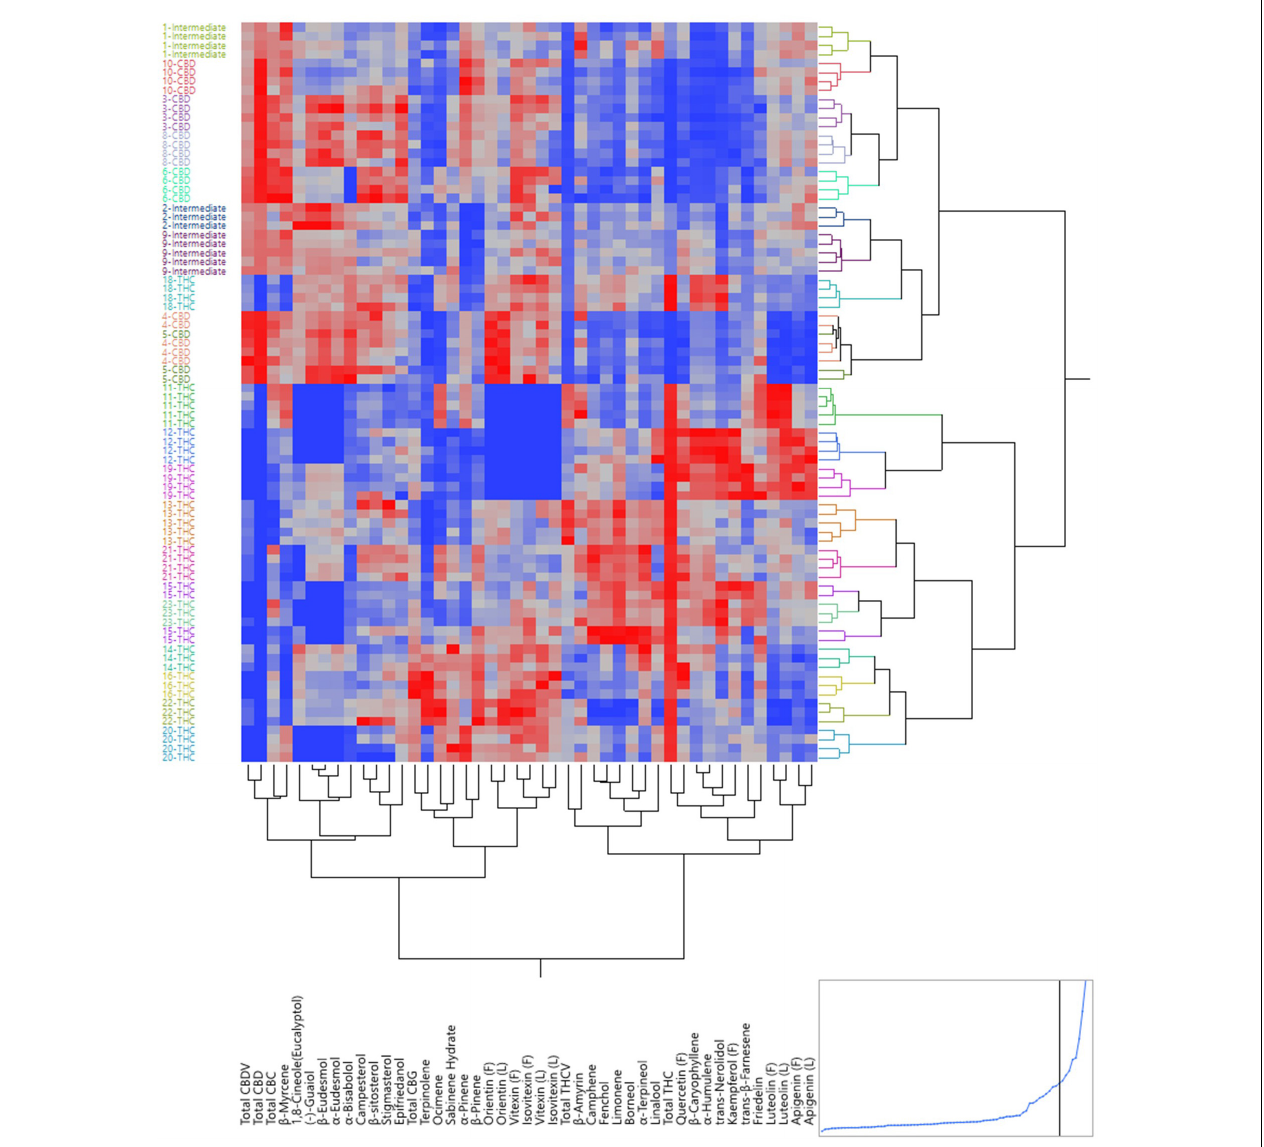
FIGURE 3 | Dendrogram by hierarchical clustering analysis using the full spectrum of secondary metabolites (in ratios) of 82 plants representing 21